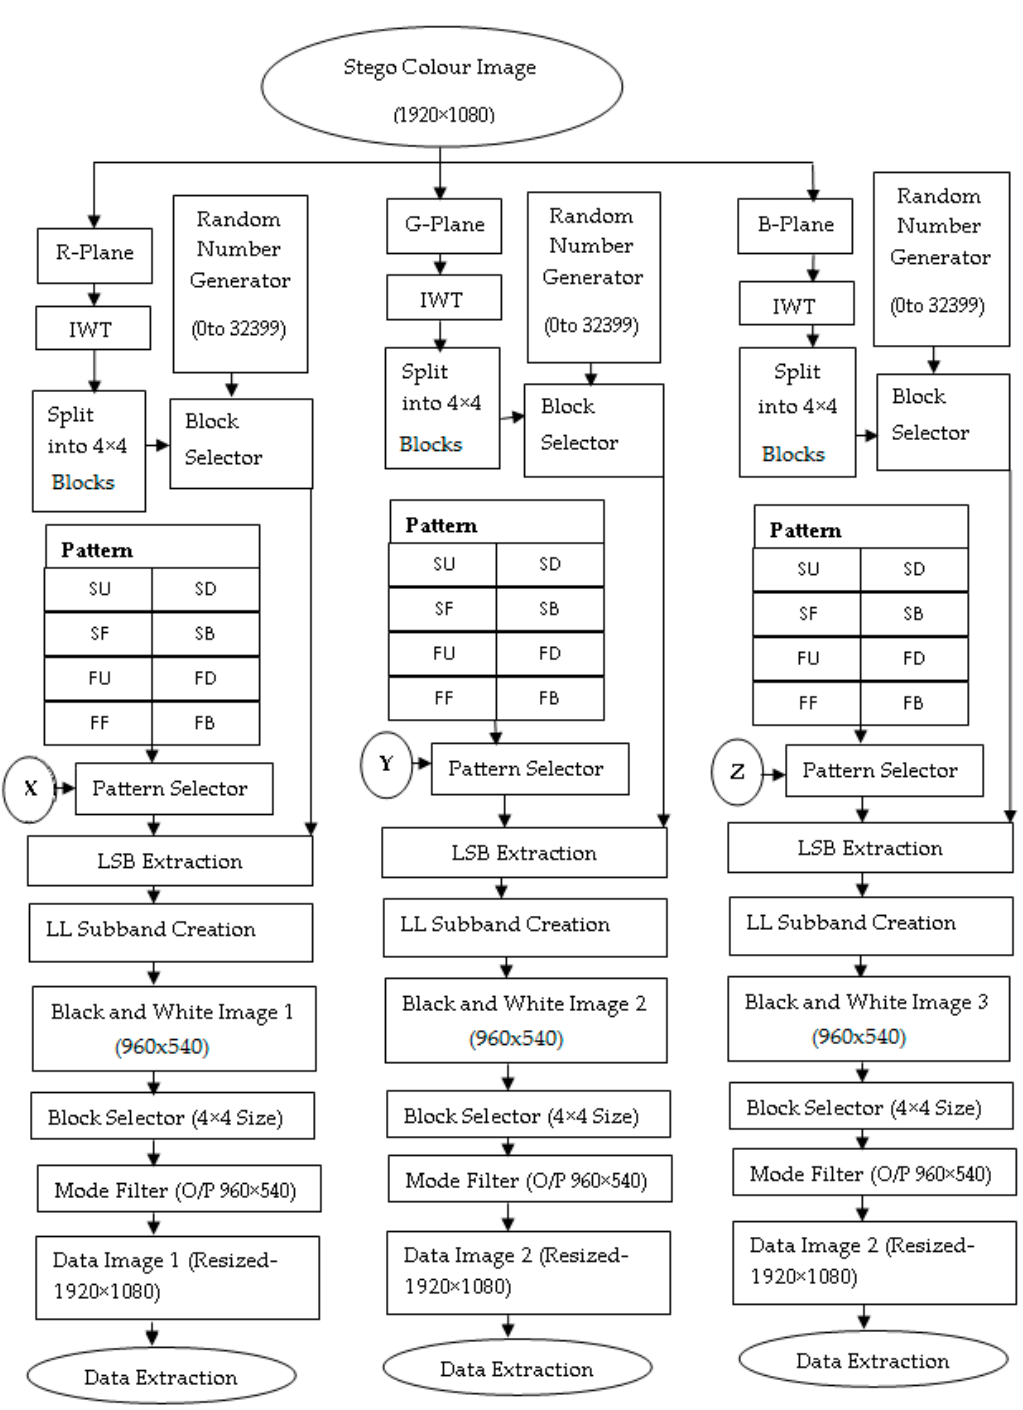
Figure 8. Flowchart representation of data extraction algorithm.